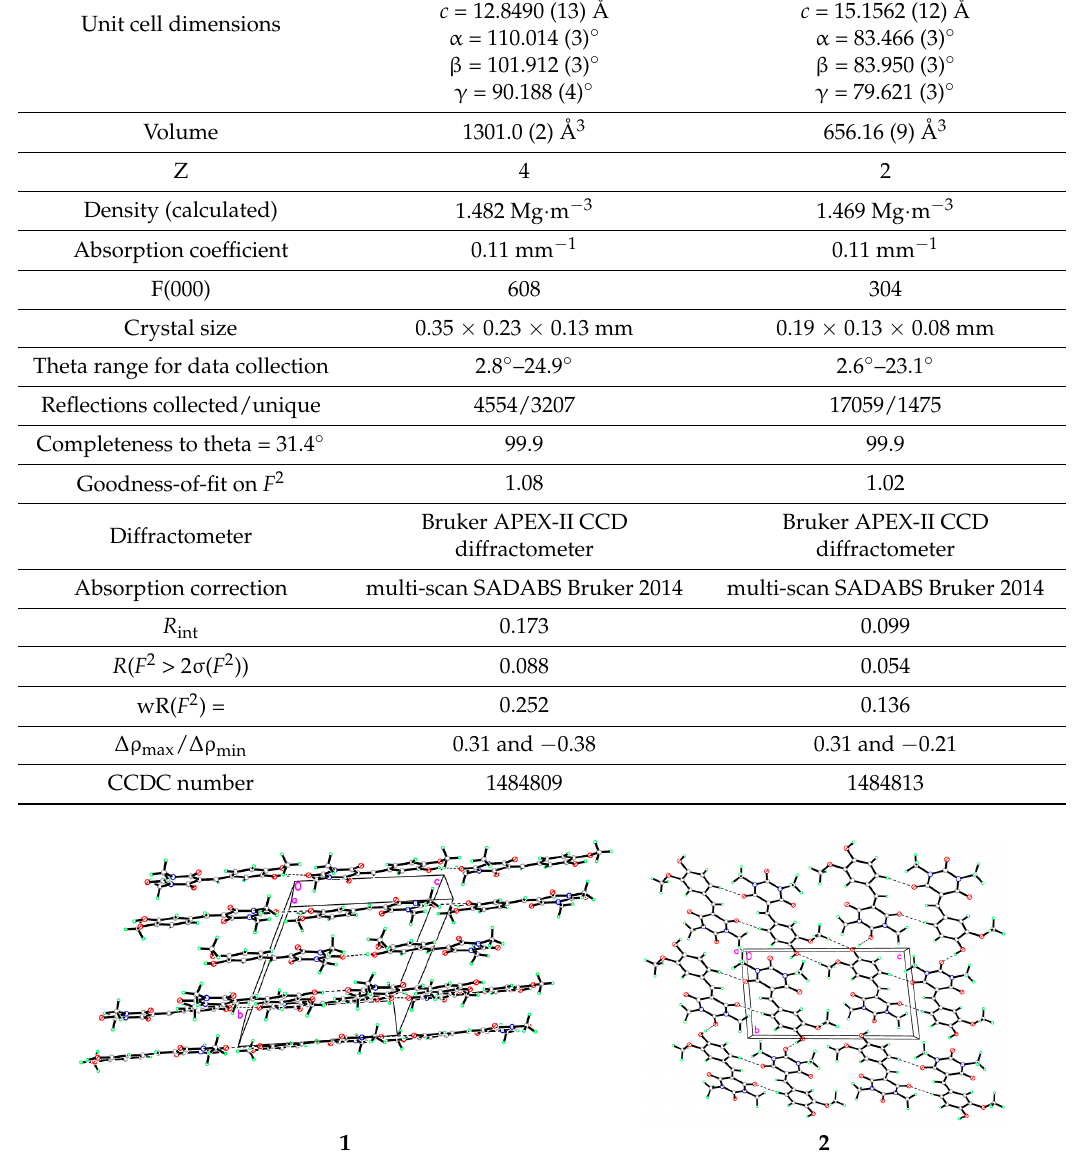
Figure 2. View of the molecular packing in compounds 1 and 2 The O–H … O and C–H … O hydrogen bonds are shown as dashed lines.